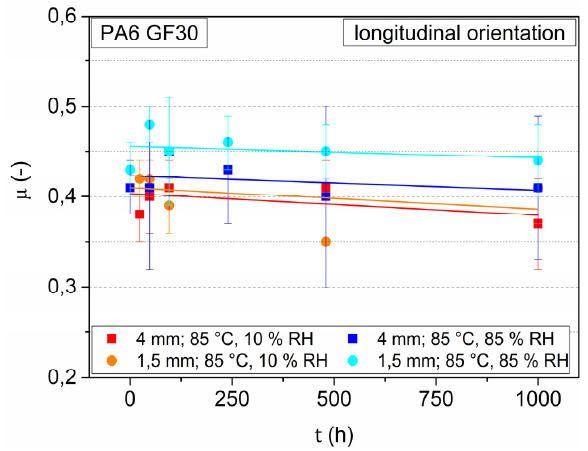
Figure 7. Change of Poisson’s ratio µ during climate storage at 85 °C, 10% RH and 85% RH for PA6 GF30 with 1.5 mm as well as 4 mm test specimen thickness.